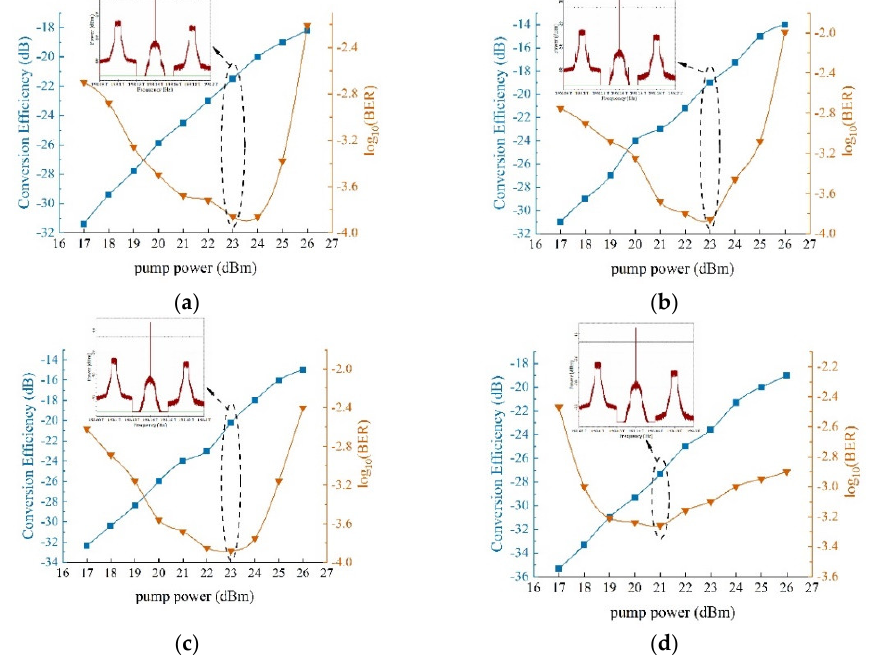
Figure 3. Measured conversion efficiency in square symbol line and BERs in triangle symbol line versus the pump signal power input into OPC. ( a ) HNLF A; ( b ) HNLF B; ( c ) HNLF C; ( d ) HNLF